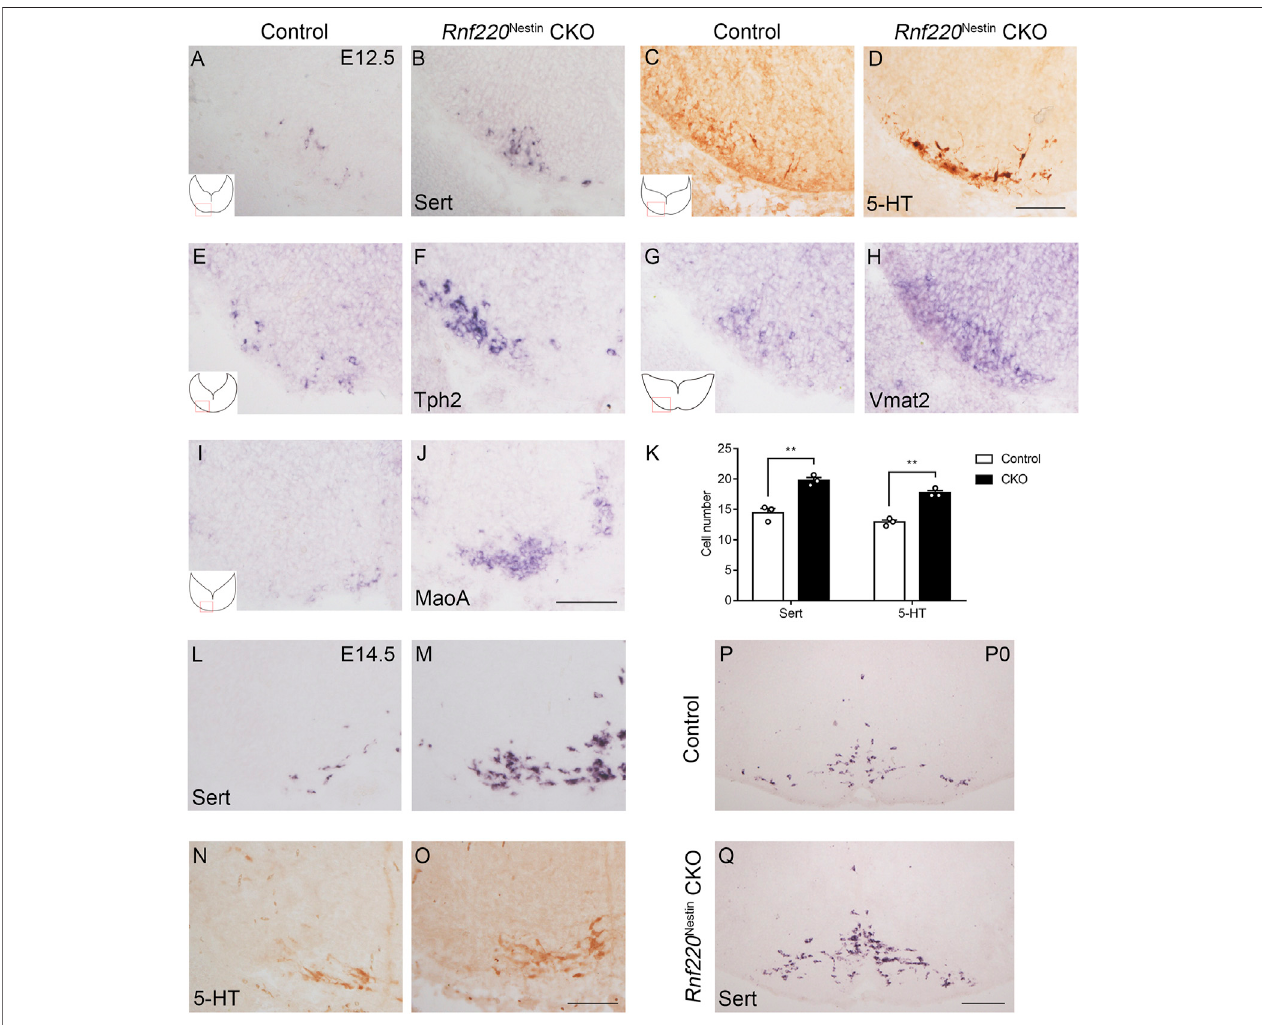
FIGURE5| TheNumberof5-HTNs isIncreased inthe Hindbrain of Rnf220 Nestin CKO Mice. (A,B) In situ hybridizationfor Sert showsincreased number of5-HTNs in Rnf220 Nestin CKO embryos (B) compared with controls (A) at E12.5. (C,D) DAB staining for 5-HT shows more 5-HTNs in Rnf220 Nestin CKO embryos (D) than in controls (C) atE12.5.Scalebar,100 μ m (D) ;alsoappliesto (A – C) . (E – J) Insitu hybridizationfor Tph2 , Vmat2 and MaoA showsincreasedexpressionsofthesegenesin Rnf220 Nestin CKO embryos (F,H,J) compared with controls (E,G,I) . Scale bar, 50 μ m (J) ; also applies to (E – I) . Insets (A,C,E,G,I) are schematic diagrams of the hindbrain level and position shown in (A – J) . (K) Quanti fi cation of Sert + and 5-HT + neurons. Data are expressed by mean ± SEM. Student ’ s t -test ( n =3 for each). **, p < 0.01. (L,M) In situ hybridization for Sert shows increased number of 5-HTNs in Rnf220 Nestin CKO embryos (M) compared with controls (L) at E14.5. (N,O) DAB staining for 5-HT shows more 5-HTNs in Rnf220 Nestin CKO embryos (O) than in controls (N) at E14.5. Scale bar, 100 μ m (O) ; also applies to (L – N) . (P,Q) In situ hybridization for Sert shows more 5-HTNs in Rnf220 Nestin CKO mice (Q) than in controls (P) at postnatal day 0 (P0). Scale bar, 200 μ m (Q) ; also applies to (P) .